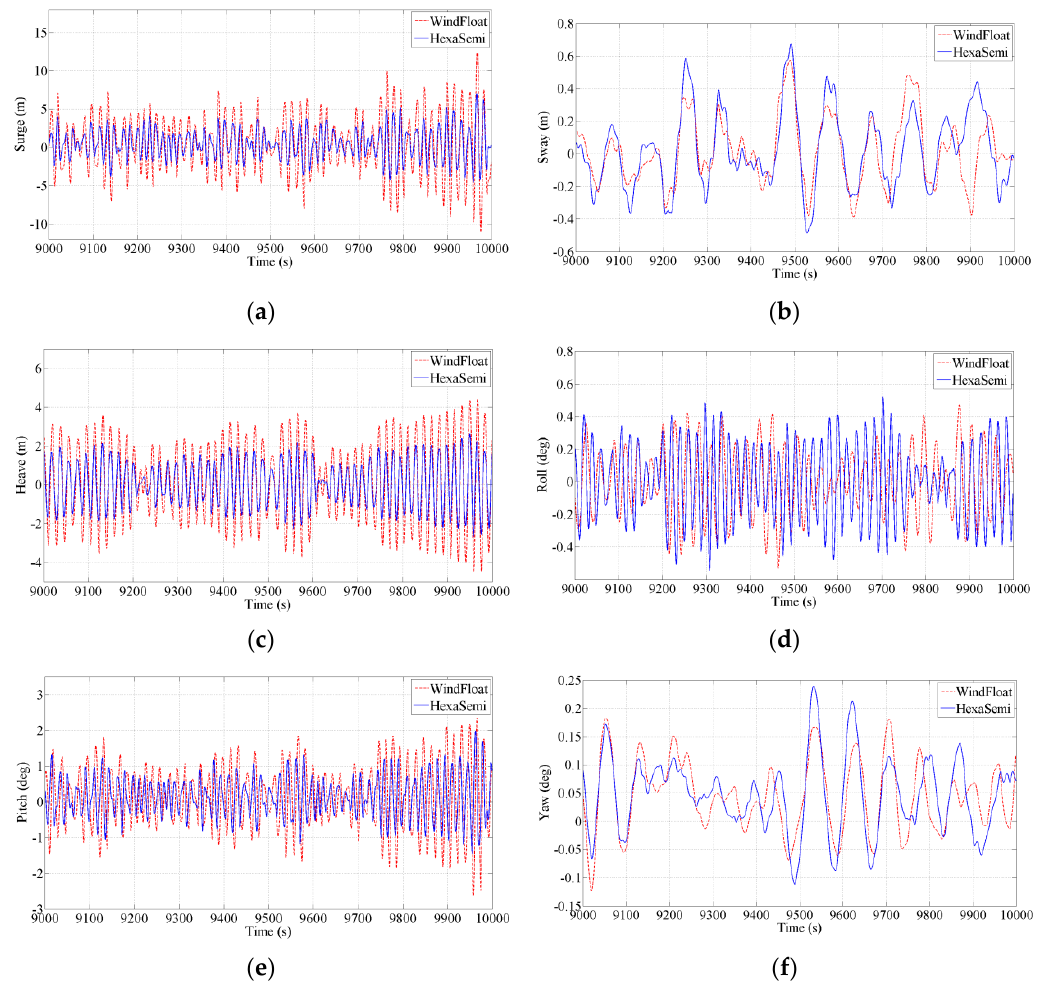
Figure 14. 6-DOFs motion response under the storm condition: ( a ) surge, ( b ) sway, ( c ) heave, ( d ) roll, ( e ) pitch, ( f )